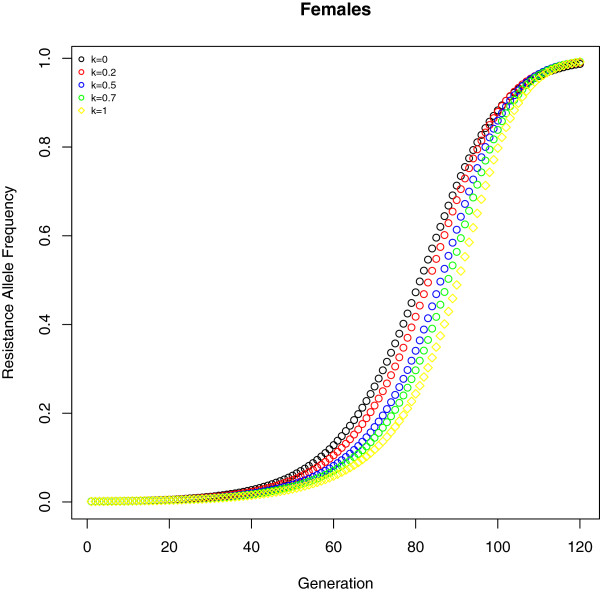
How synergists affect the spread of resistance: Predicted resistance allele frequency in females for different values of synergist impact (k = 0,0.2,0.5,0.7,1) in a specific setting (hn = 0.37,ho = 0.50,hi = 0.07,z = 0.87,so = 0.47,si = 0.46,φo = 0.11,φi = 0.33,βm = 0.02,βf = 0.82,αfo = 0.41,αfi = 0.50,αfn = 0.10,αmo = 0.38,αmi = 0.34,αmn = 0.28) that scoredy > 1.